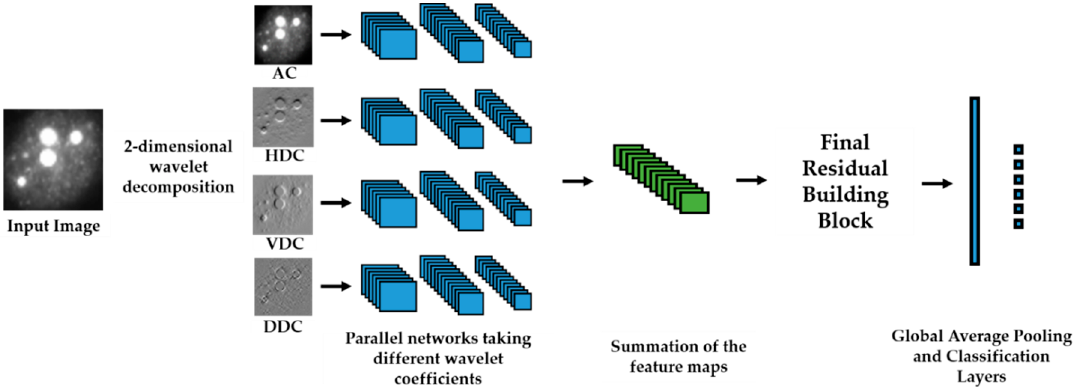
Figure 2. The schematic representation of the proposed method. “AC”, “HDC”, “VDC”, and “DDC” stand for the approximation coefficients, horizontal detail coefficients, vertical detail coefficients and diagonal detail coefficients, respectively.